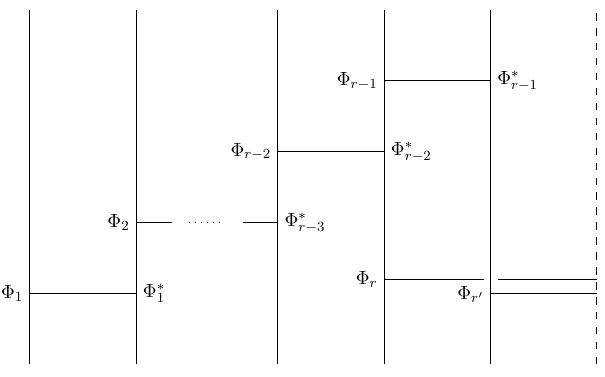
Figure 10 . DIM representation web for a general D r